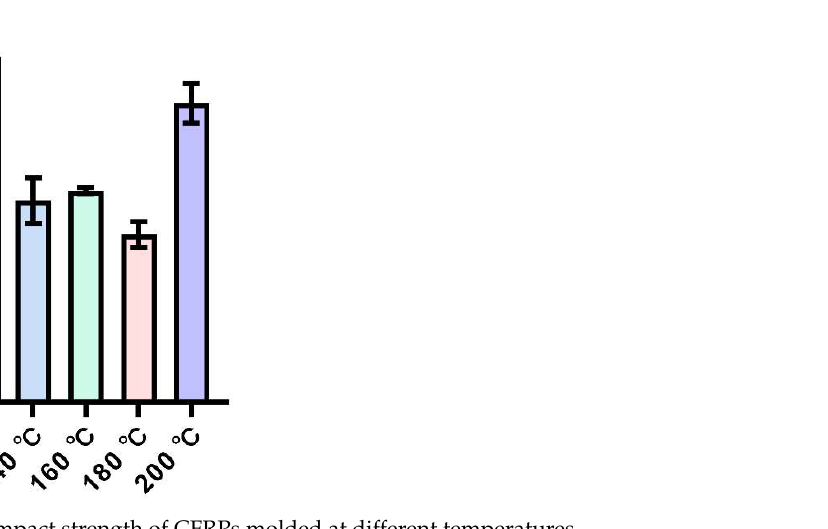
Figure 9. Impact strength of CFRPs molded at different temperatures.